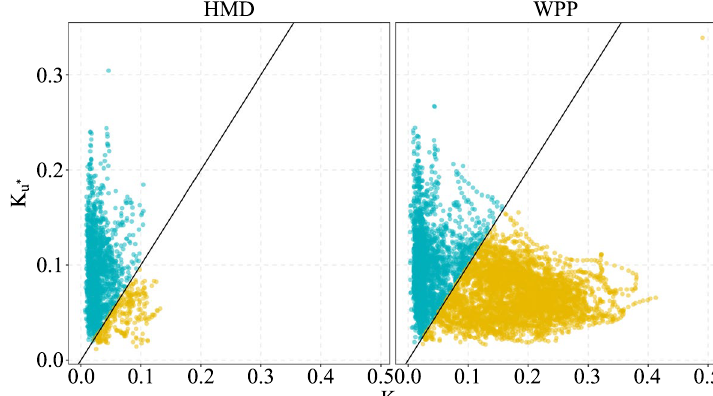
Fig. 14 K u and K ∗ u value in countries from HMD and